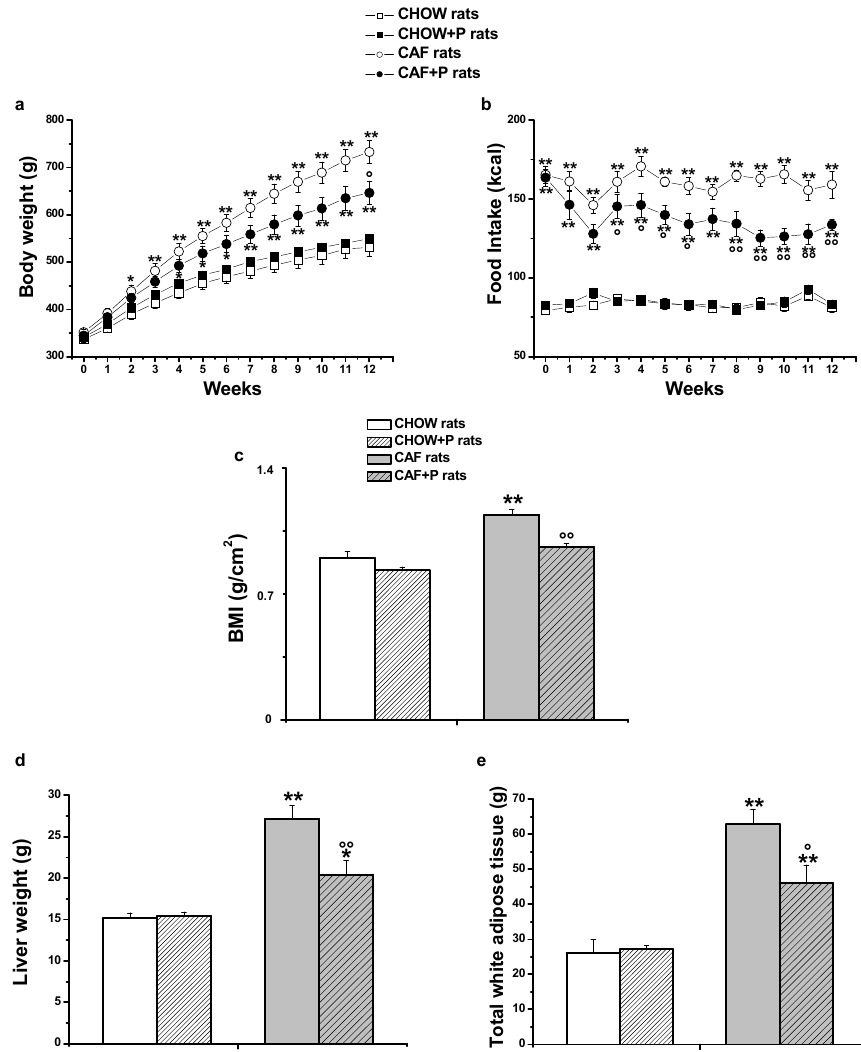
Figure 1. Body weight (g) ( a ) and Food Intake (kcal) ( b ) of male rats were measured daily throughout the experimental period. BMI (g/cm 2 ) ( c ), liver (g) ( d ) and total white adipose (g) tissue ( e ) weight at day 84. Data are shown as means ± SEM of 6–9 rats for each group. Two-way ANOVA and Bonferroni test: * p < 0.05, ** p < 0.01 vs. CHOW rats; ◦ p < 0.05, ◦◦ p < 0.01 vs. CAF rats. CAF: cafeteria; P: probiotic supplementation; BMI: body mass index.